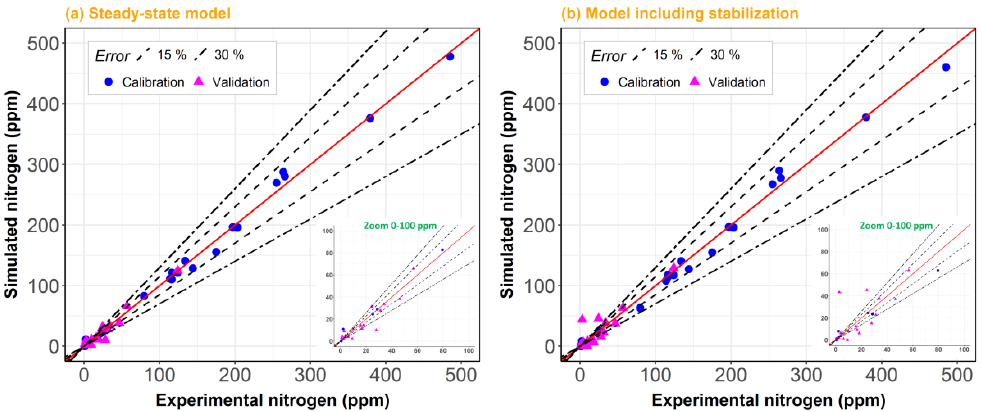
Figure 4. Parity plot of steady-state model ( a ) (RMSE = 8.23) and model including stabilization ( b ) (RMSE = 10.52) for the case with the calibration database containing 20 episodes selected by the D-optimal design.